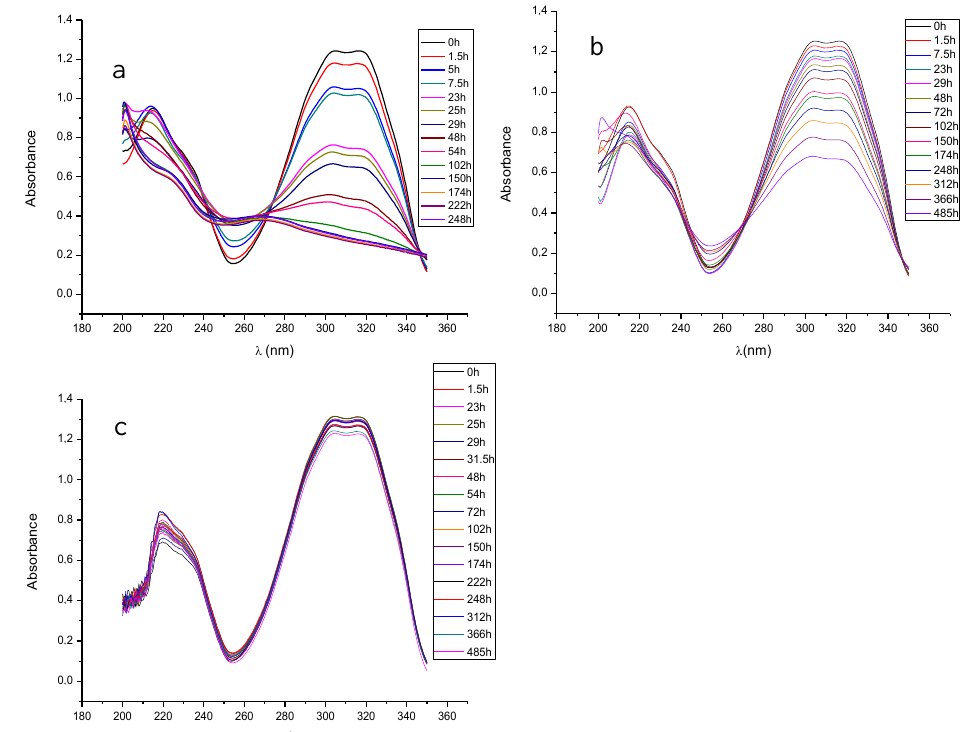
Figure 6. Degradation of trans -RSV in solution at ( a ) pH 7.4, ( b ) pH 6.4, and ( c ) pH 5 buffer, under dark conditions.